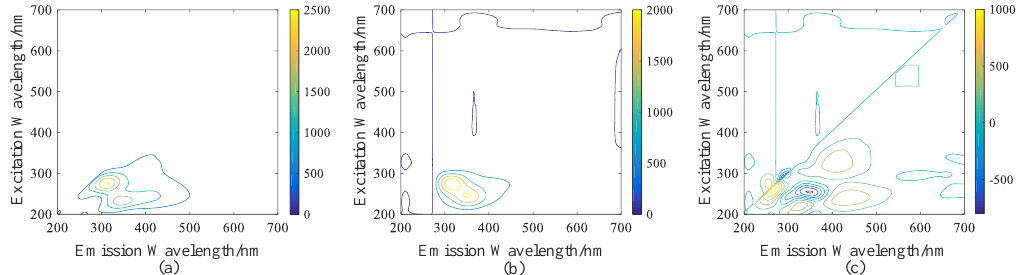
Figure 13. ( a ) Measured values; ( b ) modeling values; and ( c ) residual matrix of 4 μg/L rhodamine B based on ATLD.